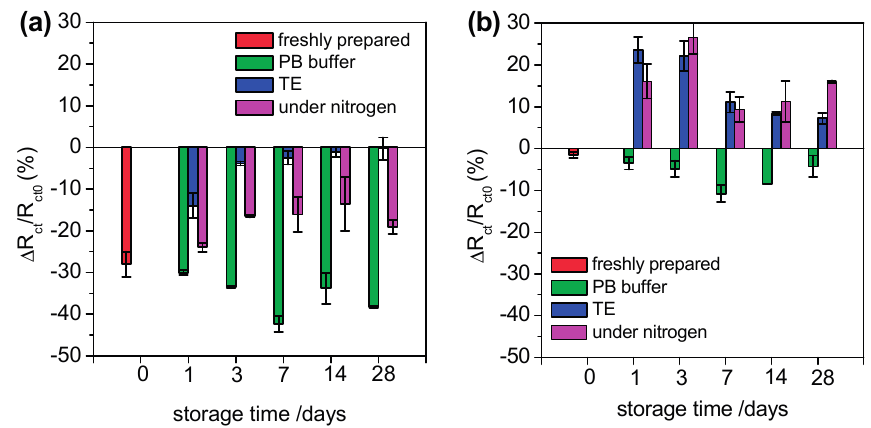
Figure 7. Influence of storage time and buffers on ( a ) interactions aptamers/thrombin by incubation of biosensor with 0.5 µM thrombin (Th) and ( b ) anti-fouling properties of